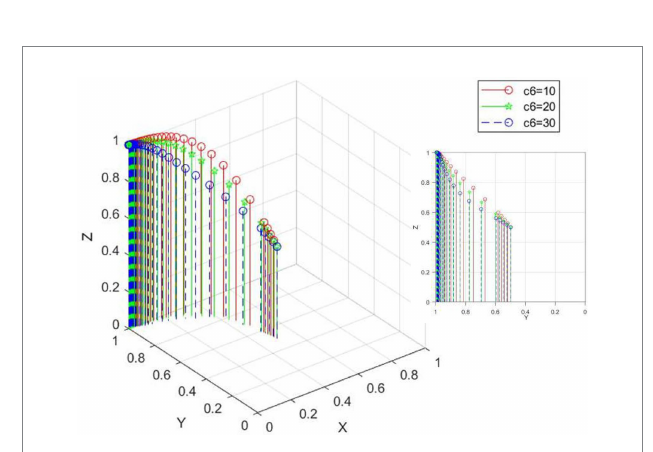
FIGURE 12 Impact map of costs of strict government regulation (Scenario